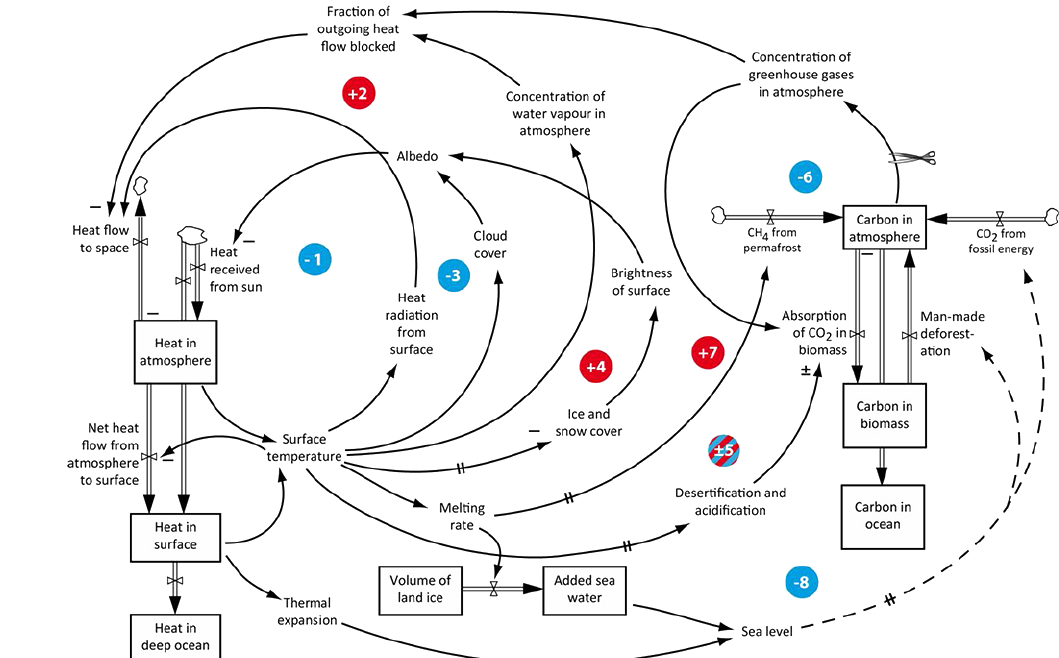
Figure 2. The eight major causal loops in ESCIMO. A plus sign in front of a loop number identifies a self-reinforcing loop, while a minus sign identifies a balancing